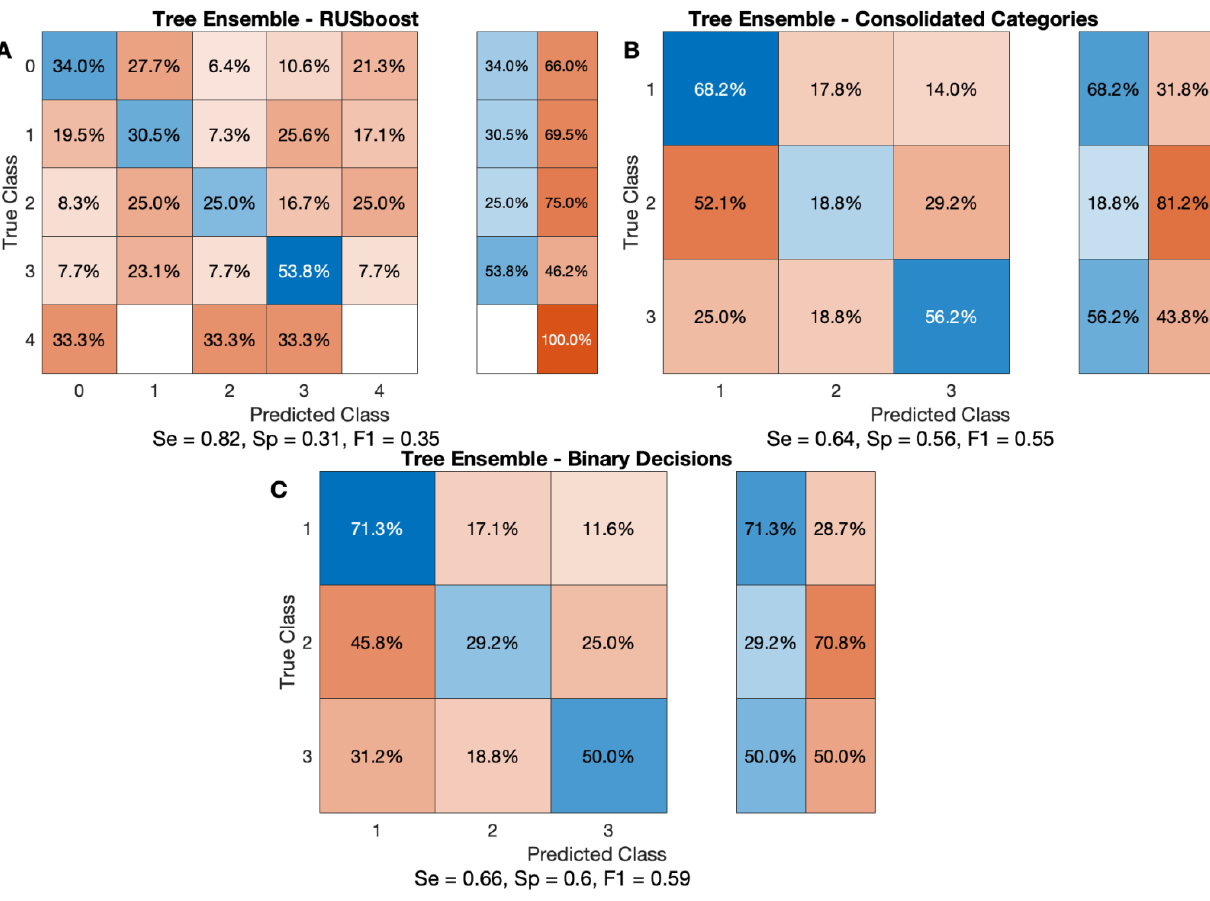
Figure 4. Confusion charts for ( A ) prediction of a tree ensemble on five categories using RUSBoost. ( B ) Prediction of the same tree ensemble for three consolidated categories. ( C ) Prediction of the binary decision model.